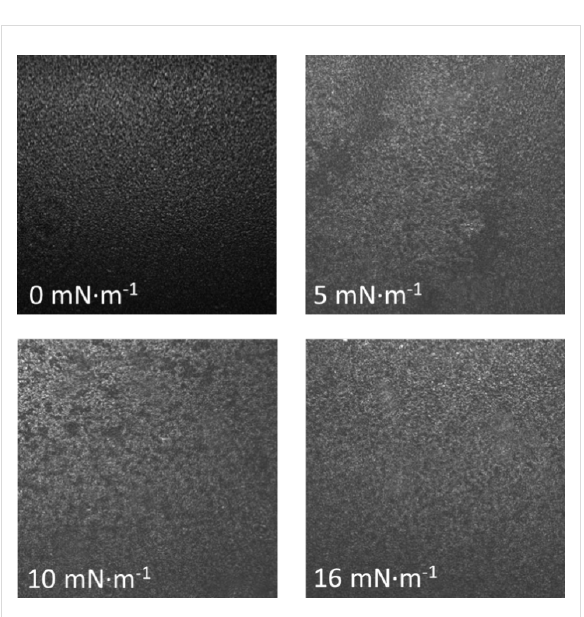
Figure 3: BAM images of 1 at the air–water interface at the indicated surface